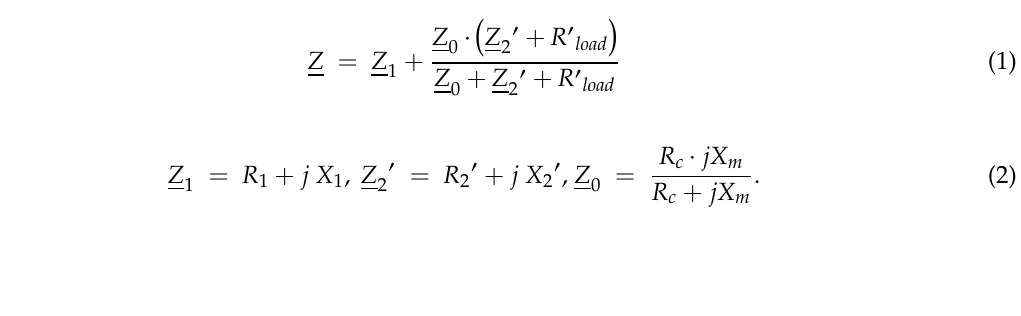
Figure 1. Transformer equivalent circuit referred to the primary side with connected active load R load .